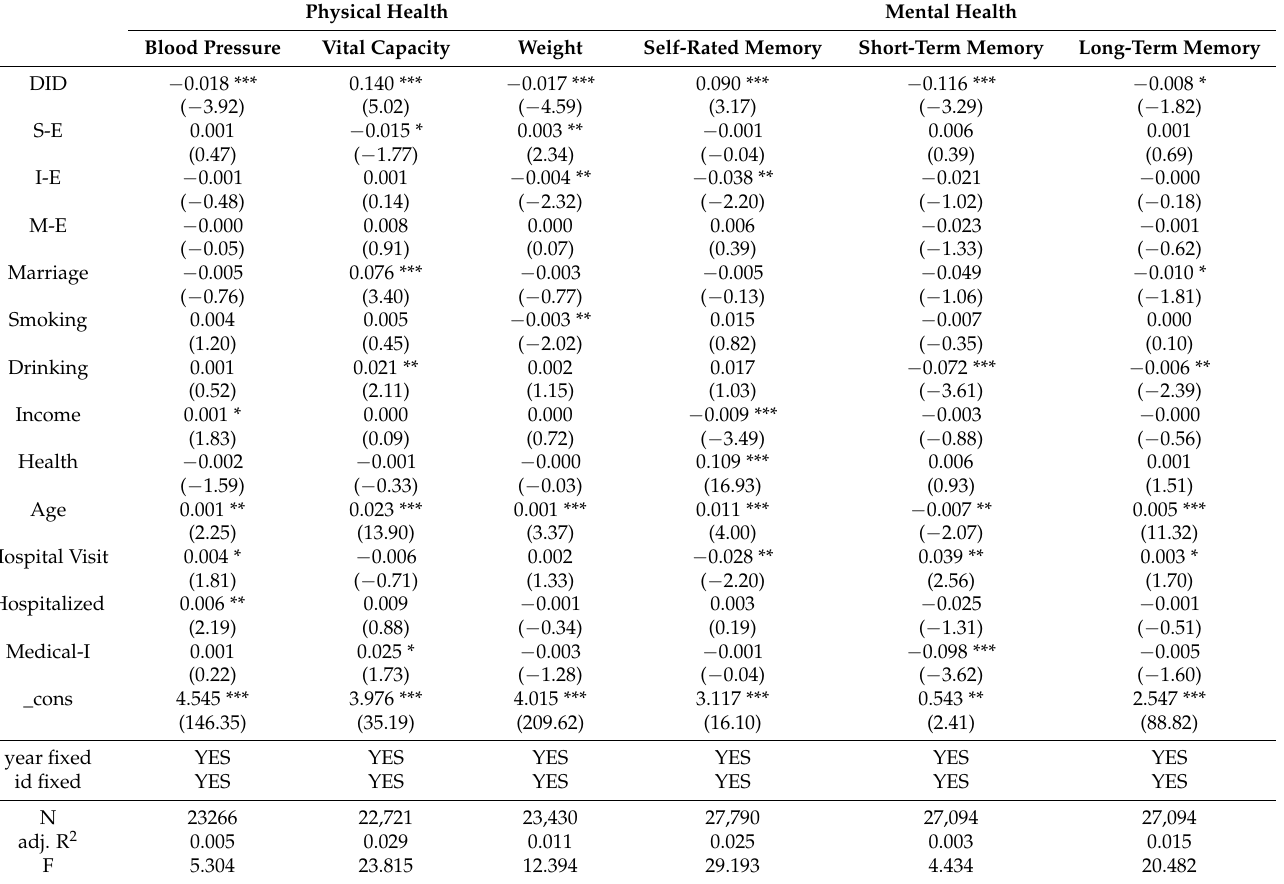
Table 3. Benchmark